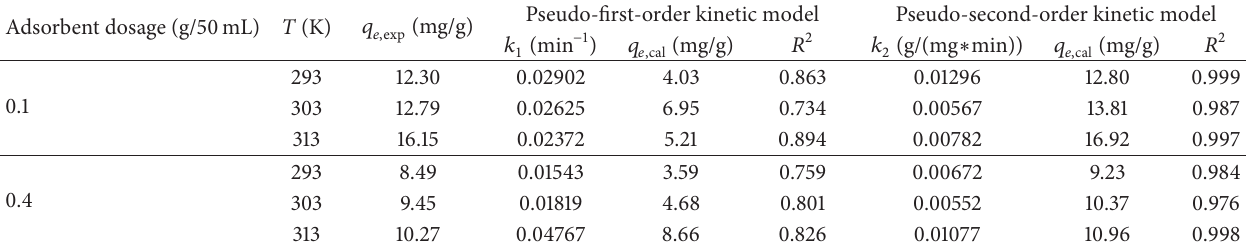
Table 4: The pseudo-first-order and second-order kinetic parameters for RY dye removal using SSCAC. Adsorbent dosage (g/50mL) T (K)